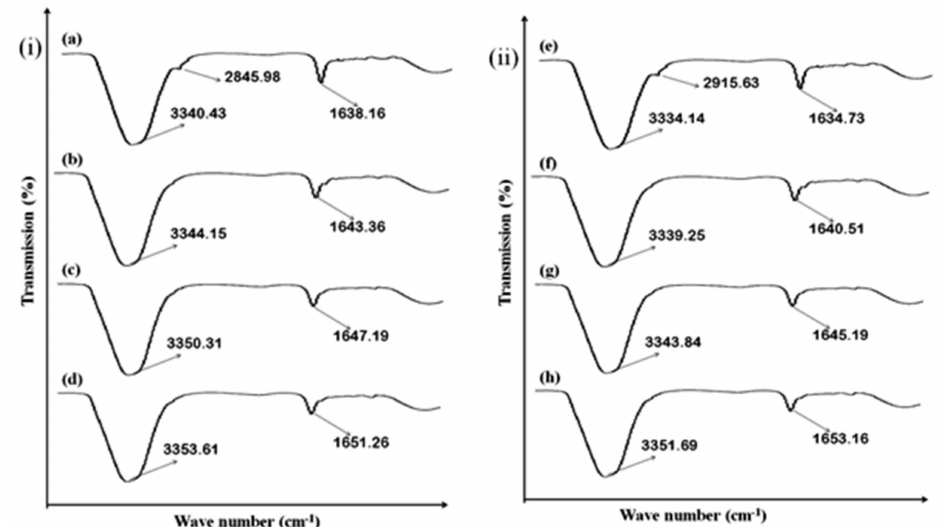
Figure 6. ( i ) . Rabbit skin epidermis ATR-FTIR: ( a ) untreated, ( b ) treated with F1, ( c ) treated with F5, ( d ) treated with F9, ( ii ) . Representation of rabbit skin dermis FTIR: ( e ) untreated, ( f ) treated with F1, ( g ) treated with F5, ( h ) treated with F9, data are expressed as mean ± SD; n =